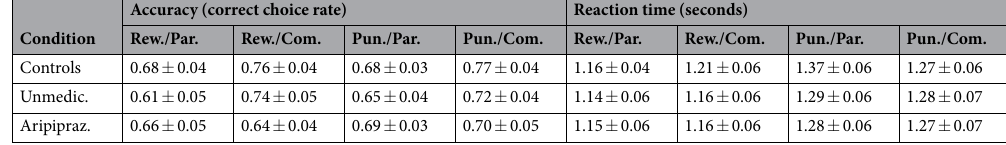
Table 2. Average behavioural data (mean ±